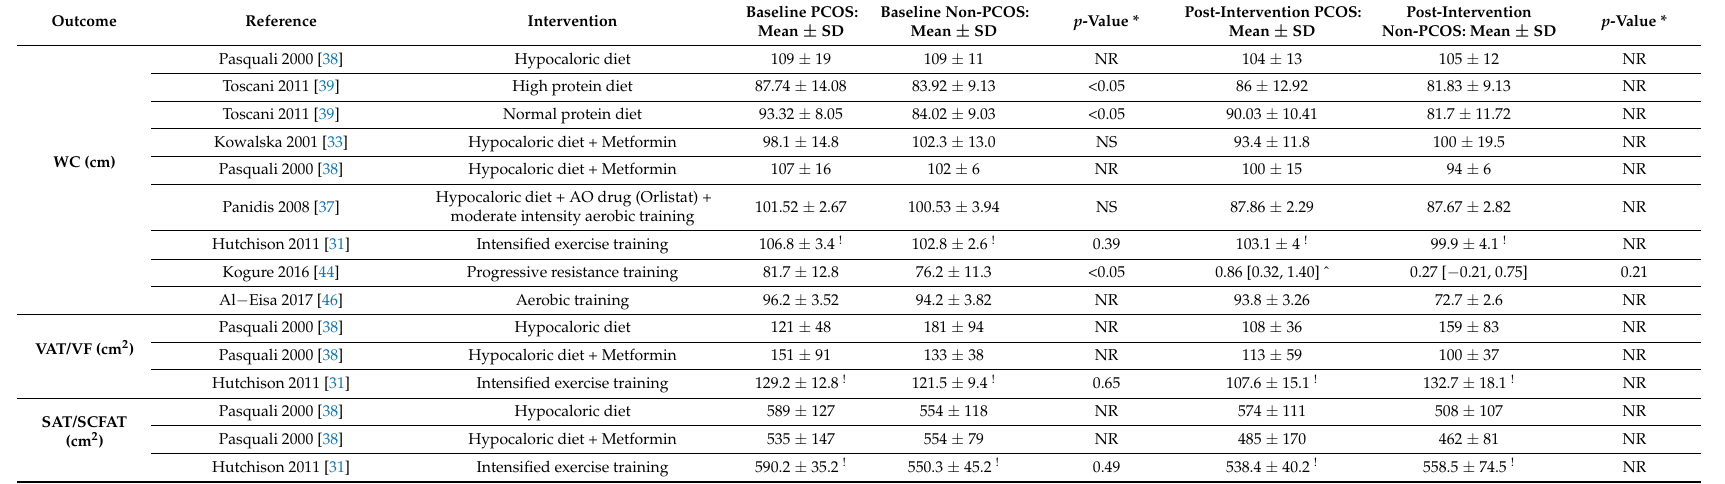
Table 2. Anthropometric